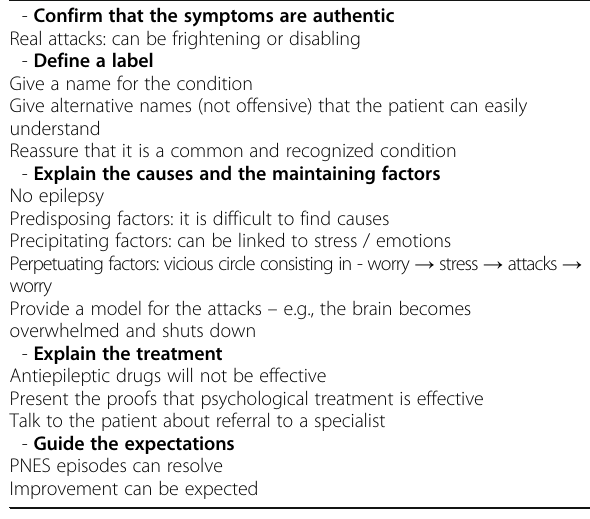
Table 5 Crib sheet with 14 core points for the strategy of PNES diagnosis communication to a patient (Adapted from the work of Hall-Patch et al. (2009), with permission)